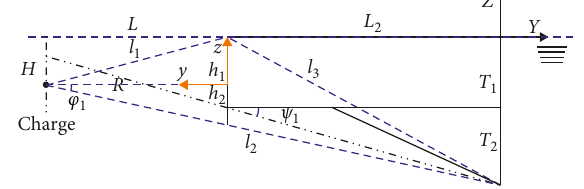
Figure 9: The condition at S